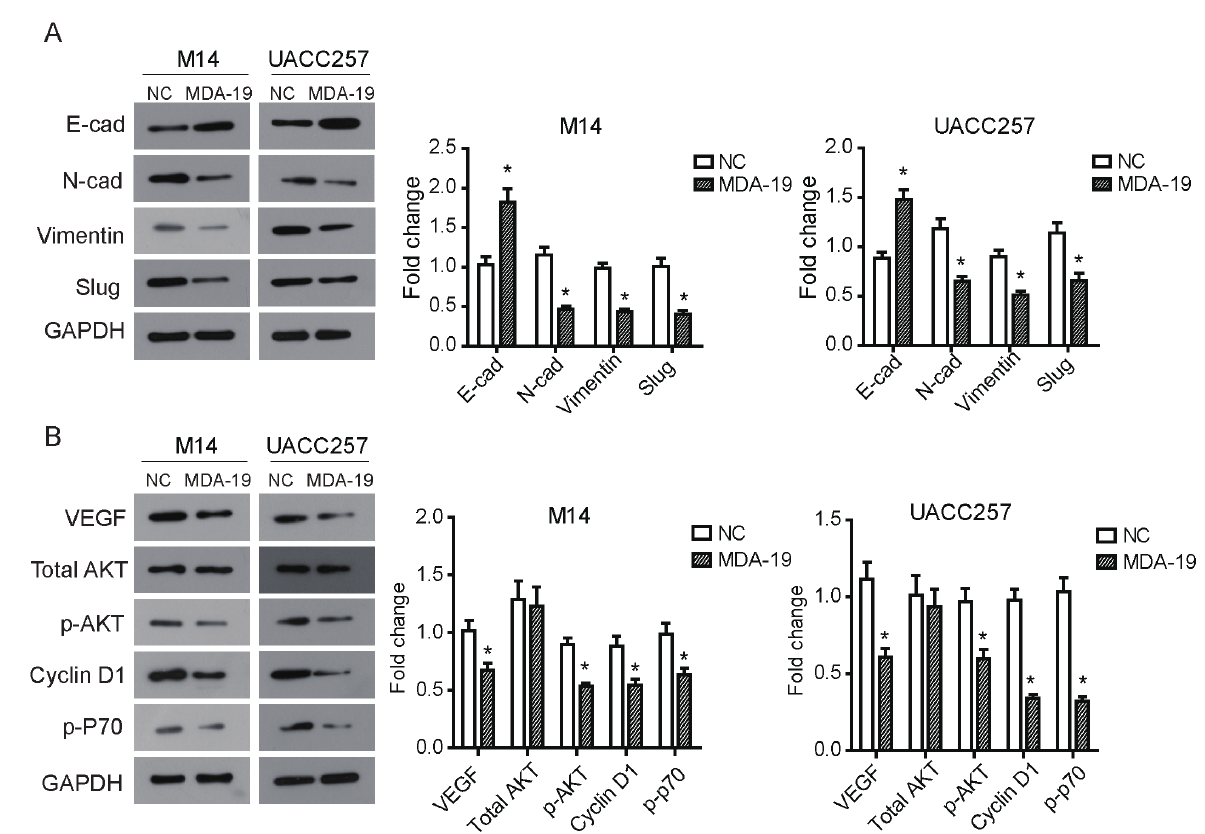
Figure 5: MDA-19 suppresses EMT process and PI3K/Akt pathway in melanoma cells. M14 cells was treated with 20 μM of MDA-19, and UACC257 cells was treated with 10 μM of MDA-19. After treatment with MDA-19 for 48h, Western blot was used to examine expression of related proteins in M14 cell (left) and UACC257 cell (right). (A) The results showed that expression of E-cad was significantly increased, while expression of N-cad, Vimentin and Slug were decreased by MDA-19. (B) The results showed that MDA-19 reduced phosphorylation levels of Akt (p-Akt), and the expression of the downstream proteins Cyclin D1 and p-P70 were also decreased. Data are expressed as the mean ± SD. MDA-19: MDA-19 treated group; NC: DMSO treated group, negative control.